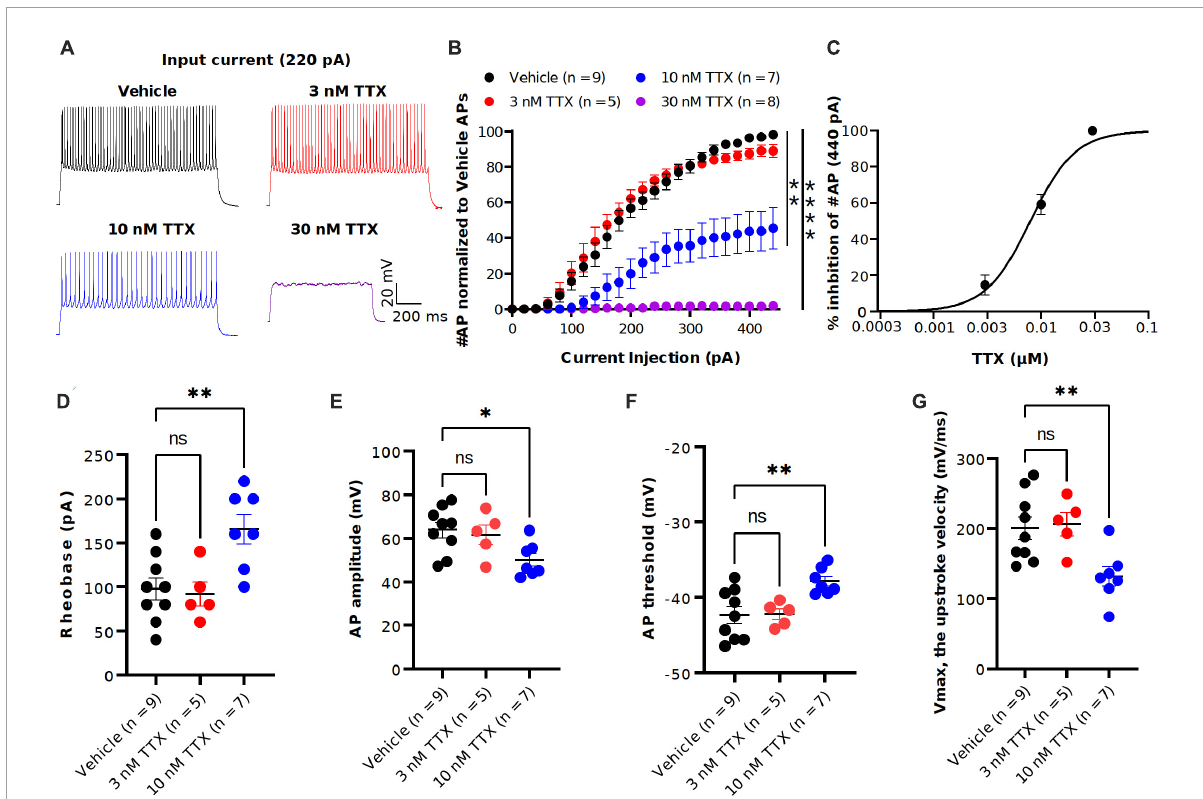
FIGURE3 TTX suppression of intrinsic excitability in cortical pyramidal neurons. (A) Representative voltage traces recorded from a cortical pyramidal neuron at a current injection of 220 pA in vehicle (black) and in presence of TTX at concentraions of 3 (red), 10 (blue) and 30 nM (magenta). (B) Mean data of number of APs as a function of various current injection for pyramidal neurons with and without TTX application. Significant differences in the AP number between the vehicle and TTX treated (30 and 100 nM) was seen (two-way ANOVA, * p < 0.05, ** p < 0.01, **** p < 0.0001). (C) Concentration-response relationship for TTX inhibition of AP firing at a current injection of 440 pA. Each concentration represents the mean of n = 5–9 neurons. The solid line is the best fit of the average data to the Hill equation yielding IC 50 = 7.9 nM. (D–G) Scatter plots showing the AP properties of pyramidal neurons include rheobase (D) AP amplitude (E) , AP threshold (F) and upstroke velocity (G) . 10 nM TTX significantly increased rheobase and AP threshold whereas AP amplitude and upstroke velocity was significantly decreased (one-way ANOVA, ∗ p < 0.05, ∗∗ p <